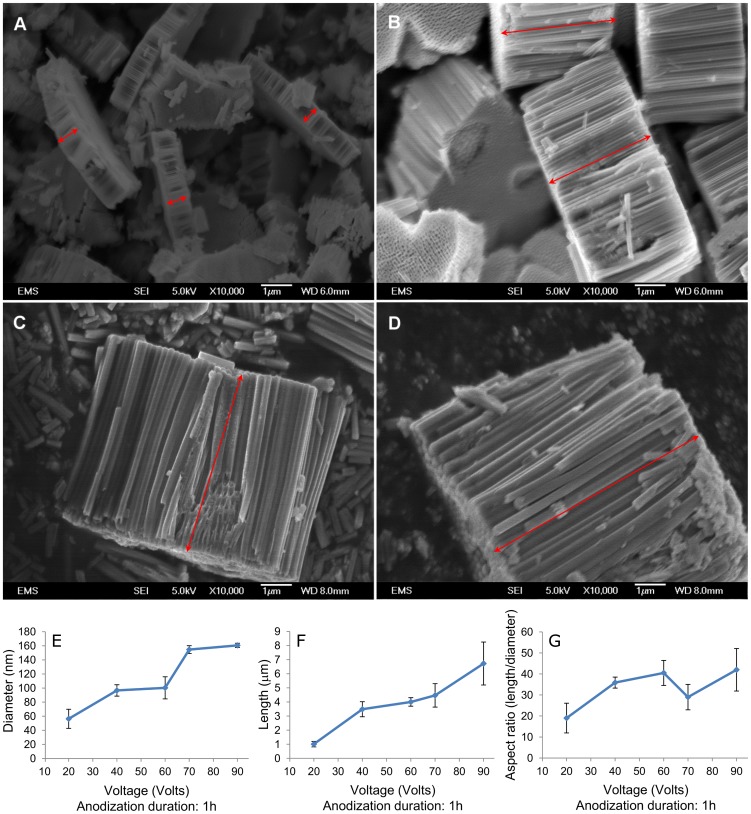
FESEM images show effect of anodization voltage on TiO2 nanotubes dimensions.Diameter and length of TiO2 nanotubes are increased as voltage is increased. (A) Shows 20 V anodized sample, (B) 40 V anodized sample, (C) 70 V anodized sample and (D) 90 V anodized sample. Effect of anodization voltage on TiO2 nanotubes dimensions is plotted in figures E–G. (E) Length, (F) diameter and (G) aspect ratio of TiO2 nanotubes are plotted versus anodization voltage. Length and diameter are enhanced as voltage is increased and aspect ratio seems to follow the same trend. Error bars show standard deviation for n = 3 samples.